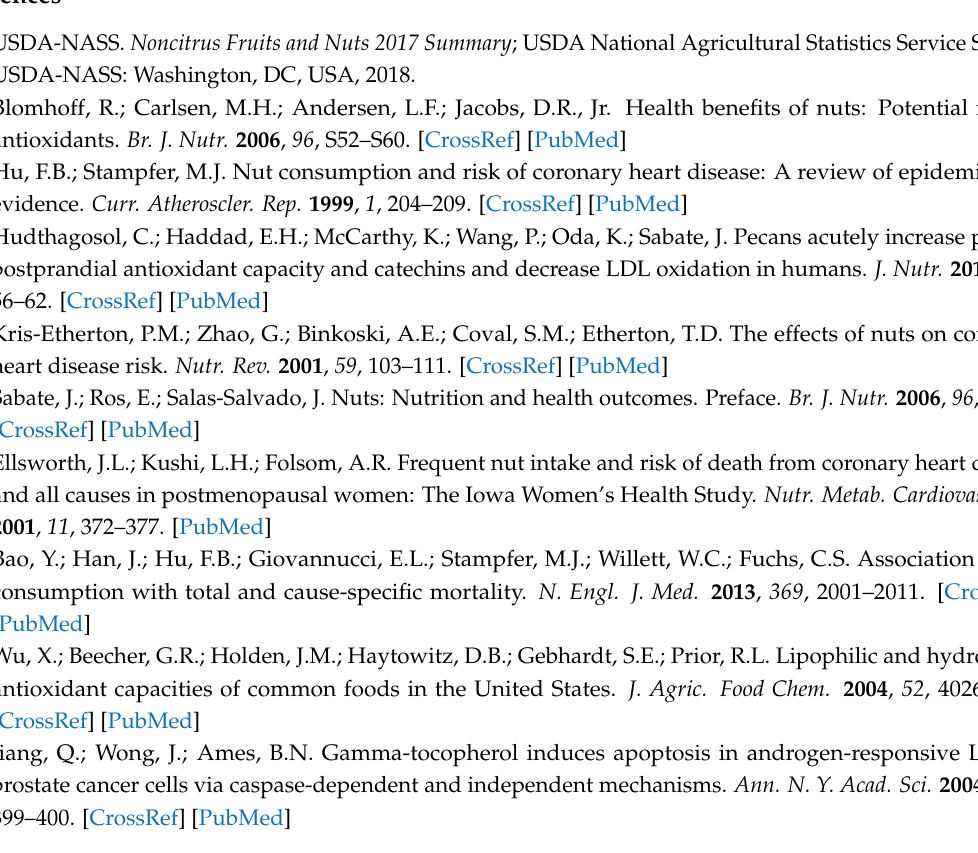
Table S1. List of mass features more abundant in Kanza. Table S2. List of mass features more abundant in Pawnee. Figure S1: Representative base peak chromatograms of Kanza and Pawnee leaves collected in 2014 and 2015. Figure S2: PCA plot of Kanza and Pawnee leaves collected in 2014 and 2015. Figure S3: Extracted ion chromatograms of Kanza and Pawnee leaves collected in 2017 from three different orchards. Figure S4: Representative MS/MS spectrum library searching